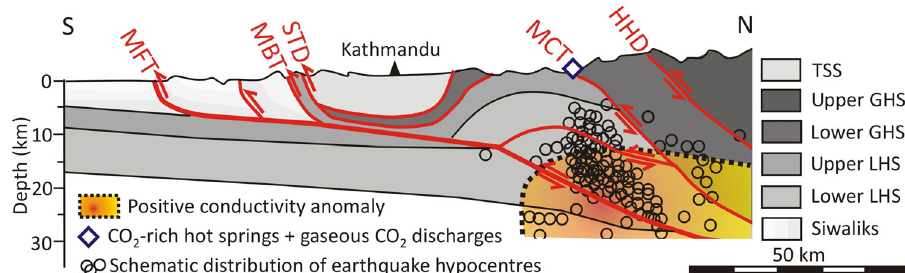
Fig. 6 Schematic geologic section across central Nepal Himalaya at the longitude of Kathmandu. The thick red line shows the Main Himalayan Thrust, MHT, which reaches the surface at the front of the Siwalik Hills, coinciding with the Main Frontal Thrust (MFT). The Main Boundary Thrust (MBT) separates the metasediments of the Lesser Himalayan Sequence (LHS) from the molasse deposits of the sub-Himalaya (the Siwaliks Hills). The Main Central Thrust (MCT) places the higher-grade metamorphic rocks of the Greater Himalayan Sequence (GHS) over the LHS metasediments. The GHS is divided into two tectono-metamorphic units (Lower-GHS and Upper-GHS) by the High Himalayan Discontinuity (HHD); geologic cross-section modi fi ed from refs. 104,122 . The red to yellow area highlights the zone of high conductivity located at depths >15 km beneath the super fi cial emergence of the MCT, as obtained from the magnetotelluric experiment of ref. 101 . The conductivity anomaly is associated with intense microseismic activity, evidenced by the schematic distribution of earthquake hypocentres (small circles). The white diamond indicates the CO 2 -rich hot springs and gaseous CO 2 discharges from the ground, located along the